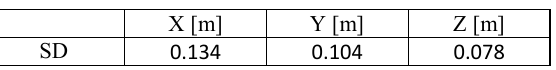
Table 7. Estimated standard deviations of positional accuracy Where SD is standard deviation.